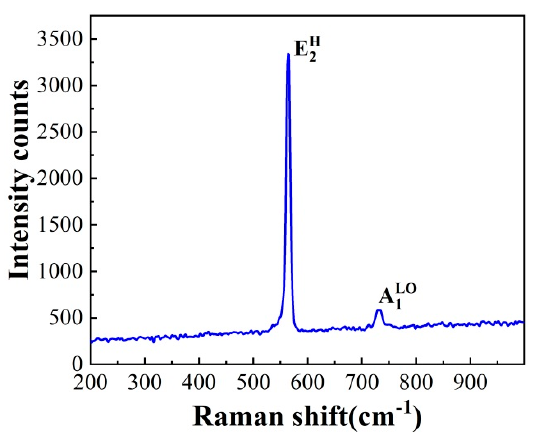
Figure 4. The Raman spectra of InGaN/GaN blue LED wafer.